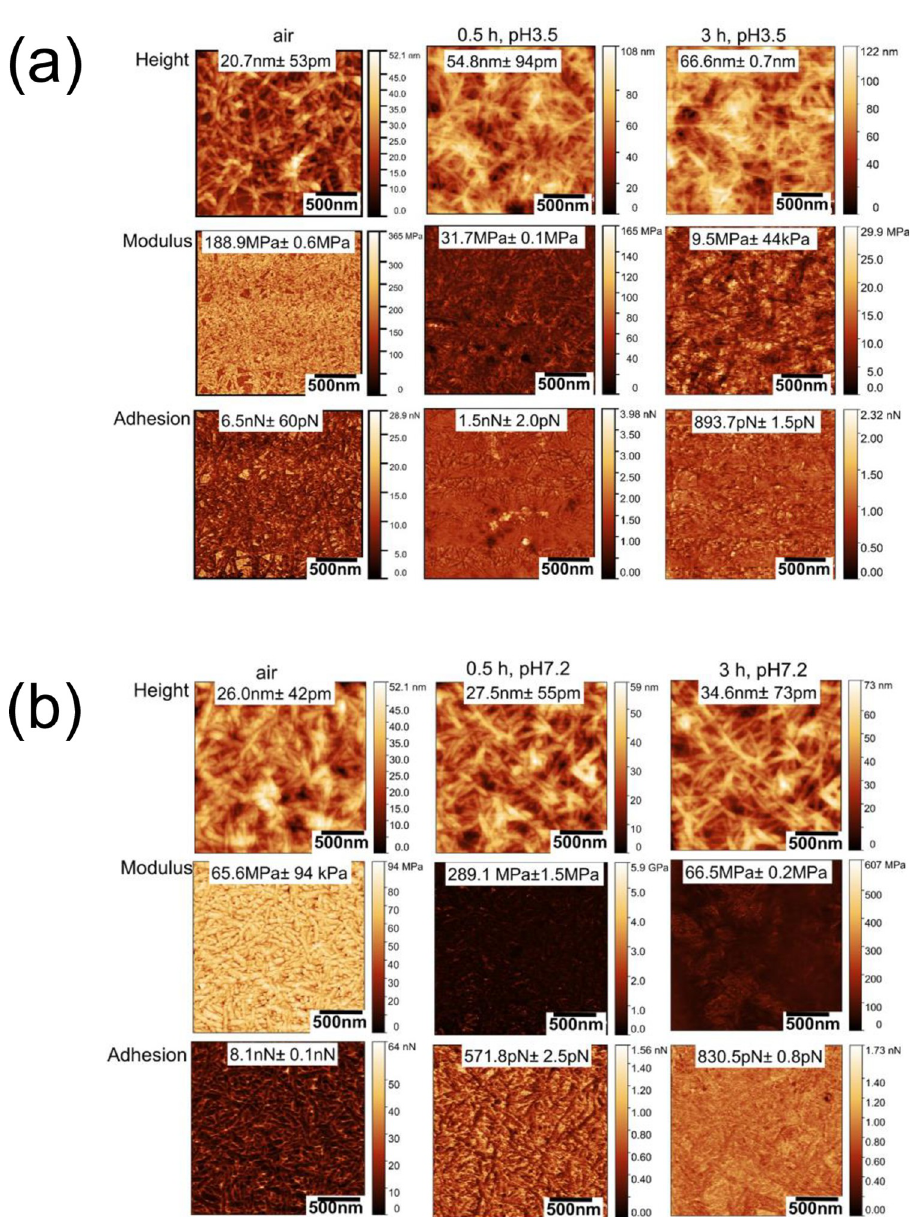
Fig 3. Sequential PFQNM images of LCNC obtained in air and then in PBS buffer after 30 minutes after 3 hours of immersion at pH 3.5 (panel (a)) and pH 7.2 (panel (b)). (scale bar: 500 nm).